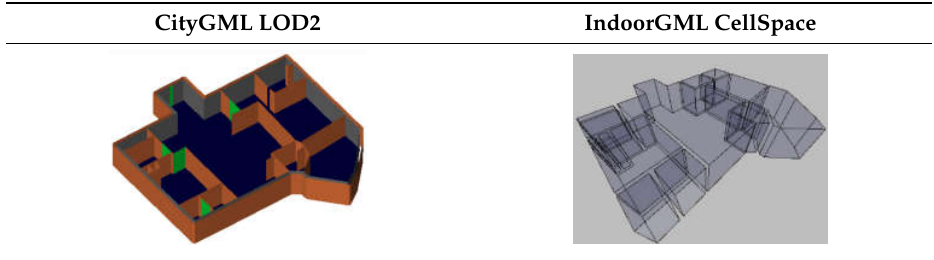
Table 9. GML data model.